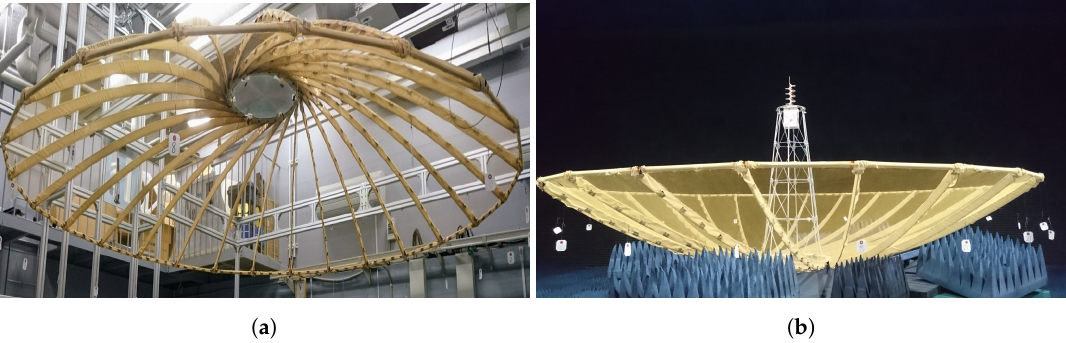
Figure 8. ( a ) Research model of deployable parabolic mesh reflector antenna; and ( b ) near-field measurement